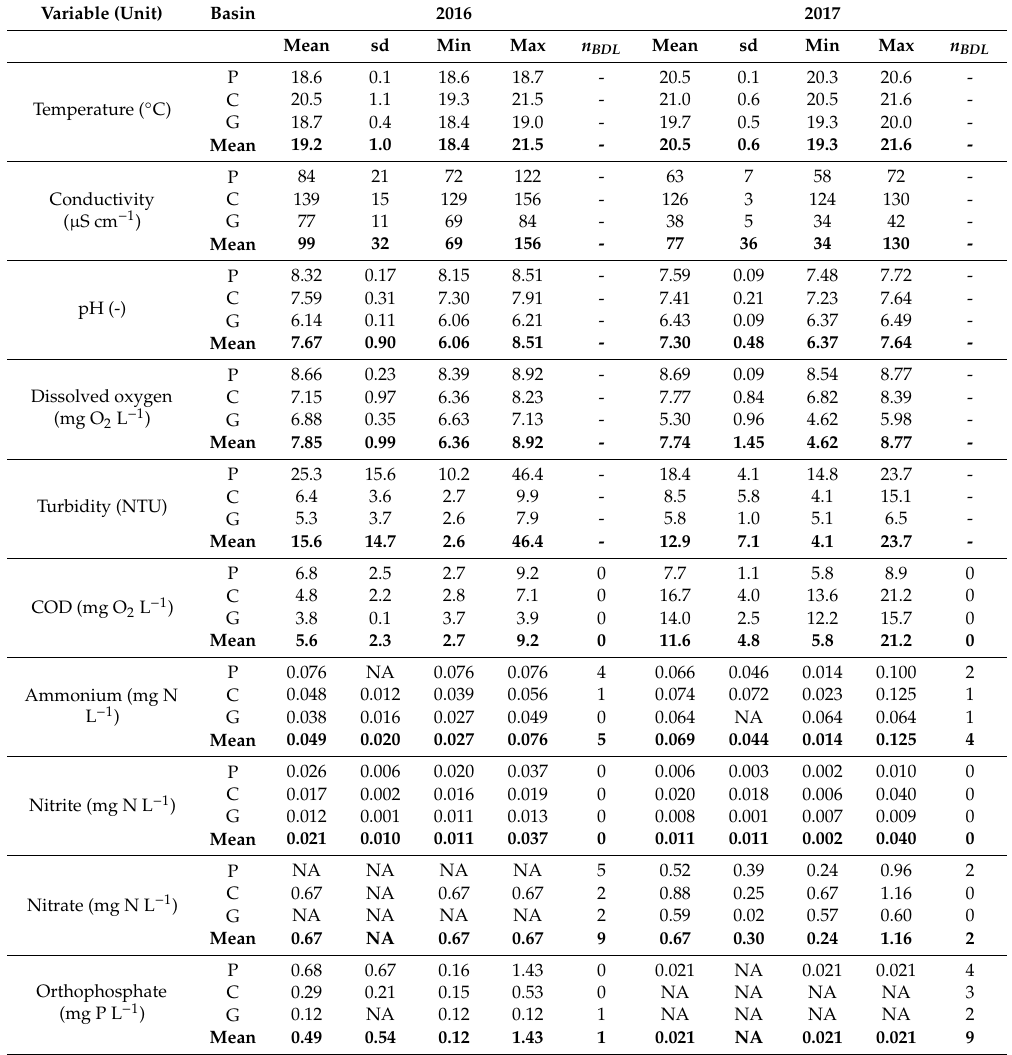
Table 1. Physicochemical variables measured in streams on San Crist ó bal island (Galapagos). The observed range (Min–Max), mean, standard deviation (sd), and number of sites below the detection limit ( n BDL ) are reported for the campaigns in 2016 and 2017, analyzing the same sites ( N = 10). Probe measurements were never below the operational limits (reported as “-” for n BDL ). NA: Not available due to a high number of sites below the detection limit; NTU: Nephelometric turbidity